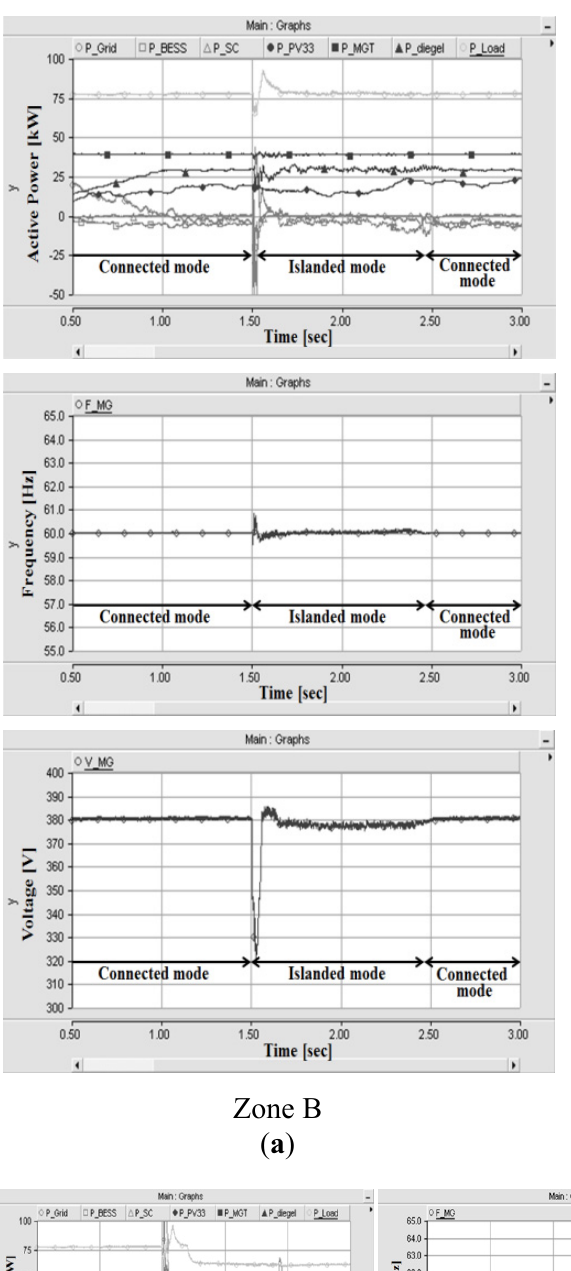
Figure 7. Active power, frequency and voltage in microgrid Zone B about Case 1, 2, and 3 respectively. ( a ) Case 1, External Fault; ( b ) Case 2, Feeder Fault with BESS in Zone B; ( c ) Case 3, Feeder Fault with PV in Zone